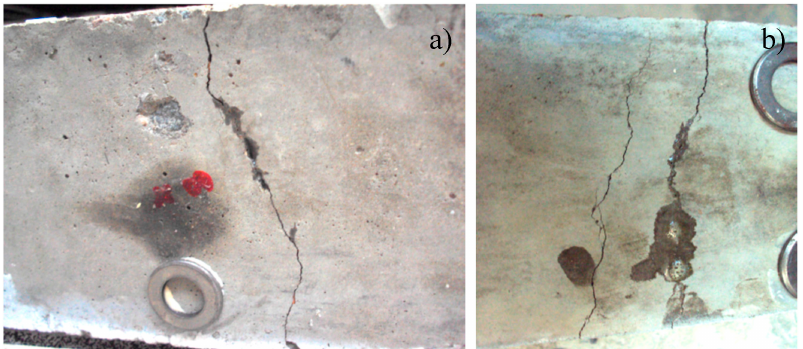
Figure 12. The middle of the bottom of the sample with: ( a ) cementitious; and ( b ) ceramic piping network. The healing agent leakage is visible.